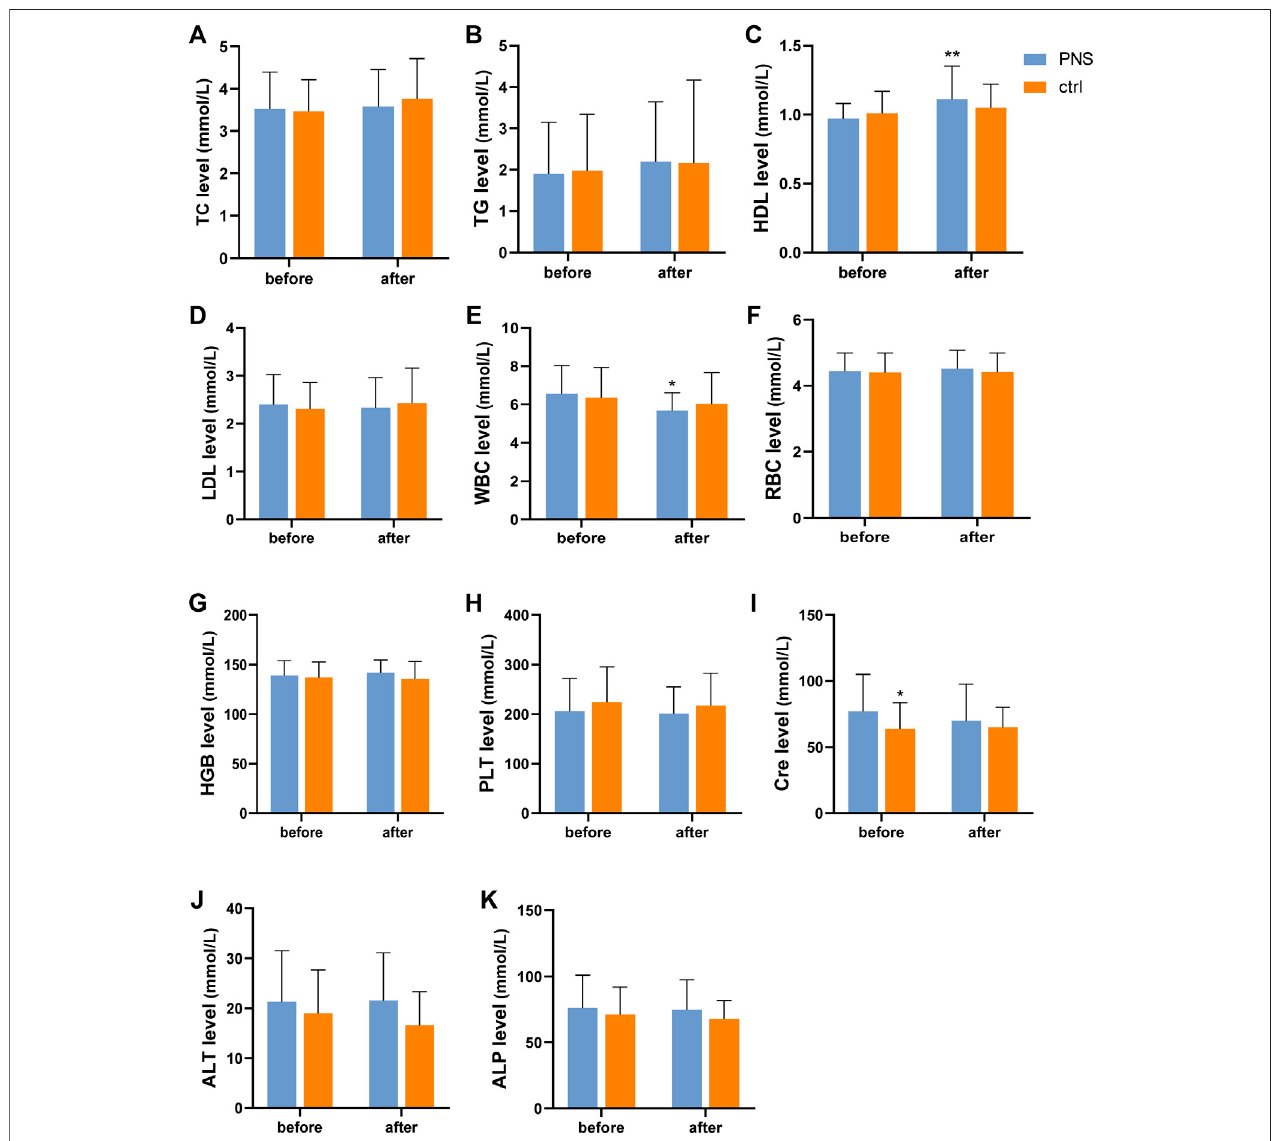
FIGURE 2 | Cell experimental protocol as described in detail in the Materials and Methods